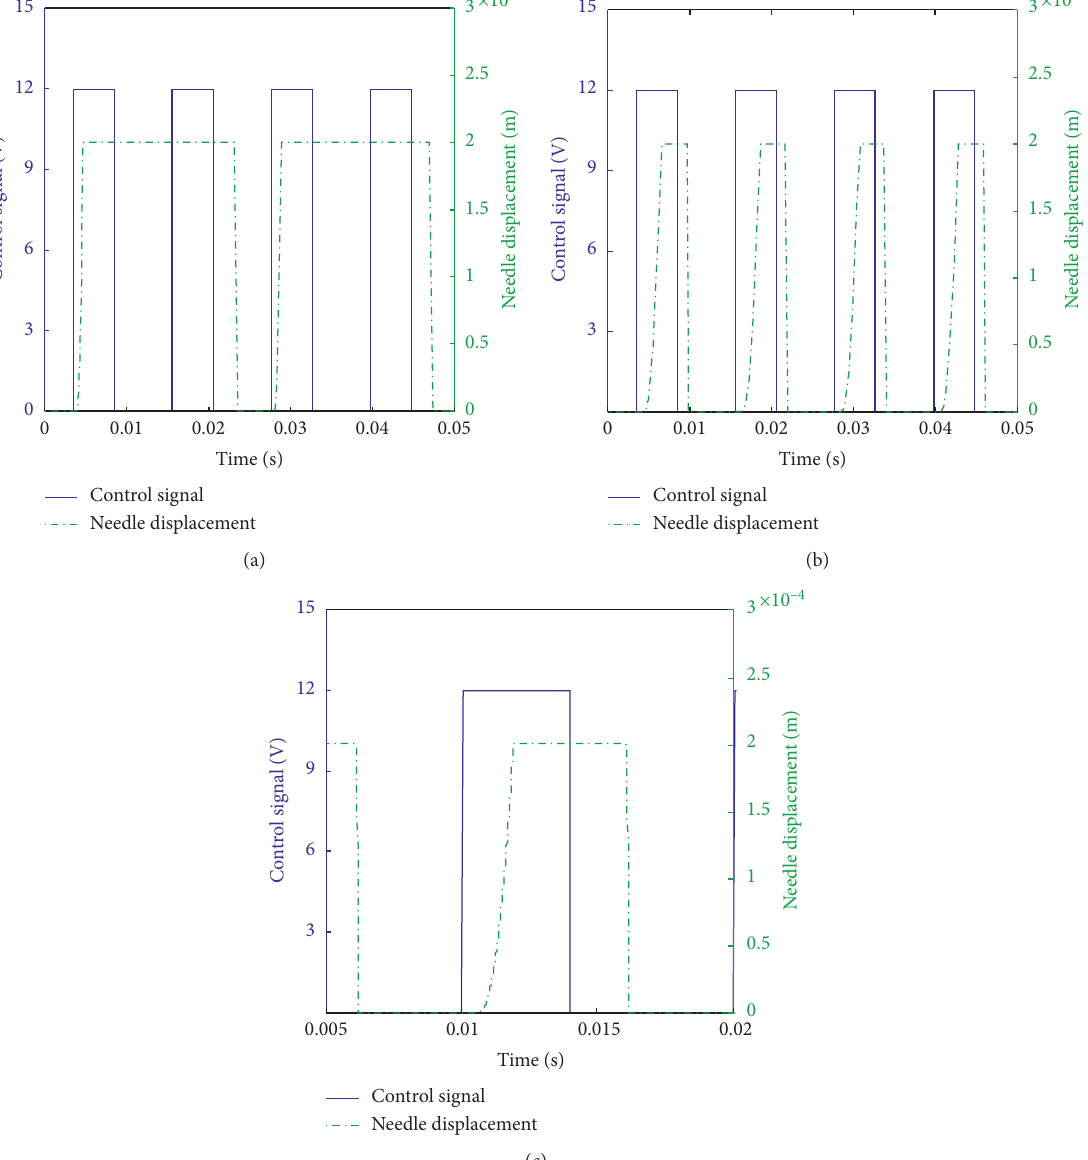
� 5.5N. (b) F � 9.5N. (c) F � 8.0N. 0 . (a) F 0 0 0